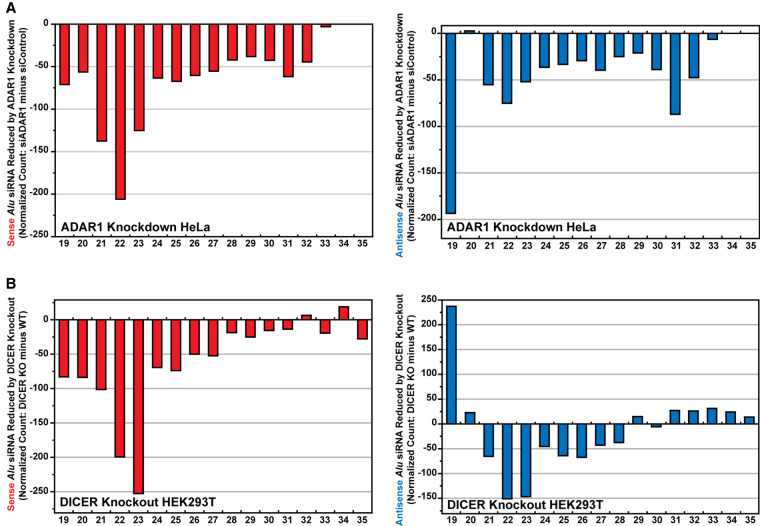
Reduced expression of Alu siRNAs in ADAR1 or DICER depleted cells. (A) The length distribution of read numbers of sense and antisense Alu siRNAs reduced by ADAR1 knockdown in HeLa cells. (B) The length distribution of read numbers of sense and antisense Alu siRNAs reduced by DICER knockout in HEK293T cells. Read numbers were first normalized: The read number of Alu siRNAs was divided by the read number excluding miRNA and Alu siRNAs from the total small RNA read number and multiplied by one million. Then, the normalized Alu siRNA read number of ADAR1 knockdown (siADAR1 HeLa) or DICER knockout (DICER null HEK293T) cells was subtracted from that of control cells (siControl HeLa or WT HEK293T), and the difference was plotted on the y-axis. A negative number on the y-axis indicates a decrease in the normalized number of reads after ADAR1 knockdown or DICER knockout. The x-axis is the number of bases in the siRNA sequence.